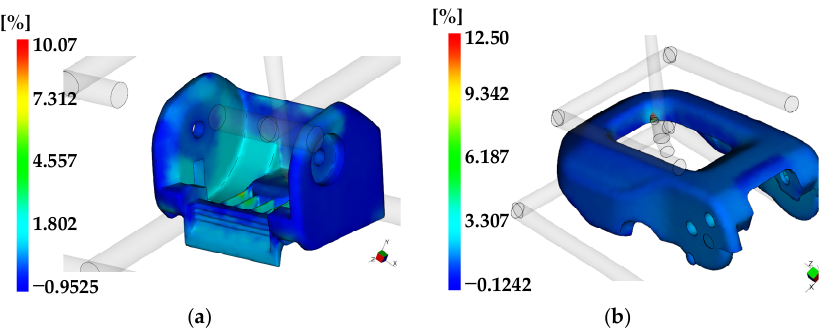
Figure 6. Average shrinkage of pivot sub-assembly and open lever existing in mass production. ( a ) Pivot sub-assembly. ( b ) Open lever.